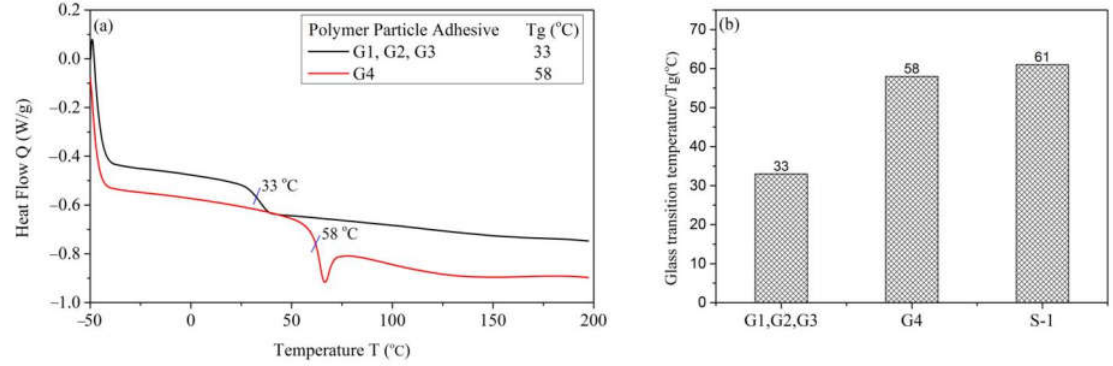
Figure 6. ( a ) The DSC curve of polymer particle adhesive (G1, G2, G3 and G4); ( b ) glass transition temperature (Tg) of polymer particle adhesive (G1, G2, G3, G4 and S-1).